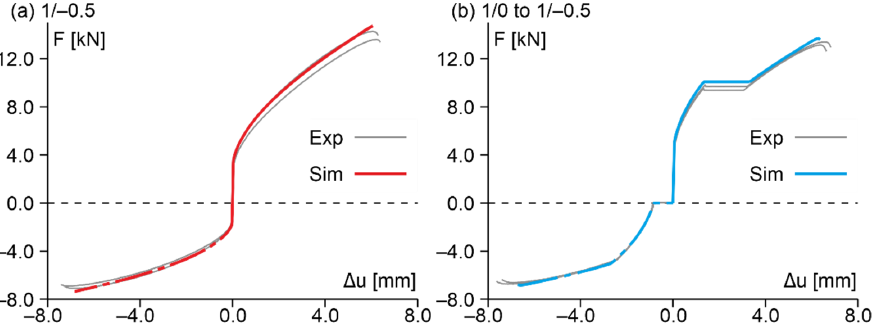
Figure 3. Force-displacement plots of experiment and simulation (axis 1 solid lines, axis 2 dash- dotted lines): ( a ) 1/ − 0.5, ( b ) 1/0 to 1/ − 0.5 .